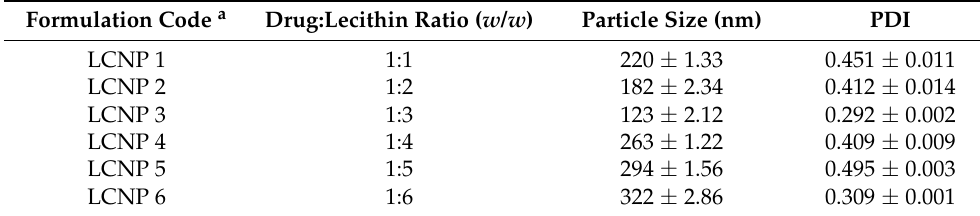
Table 1. Effect of drug:lecithin ratio on the particle size and PDI of RTG-LCNP. Formulation Code a